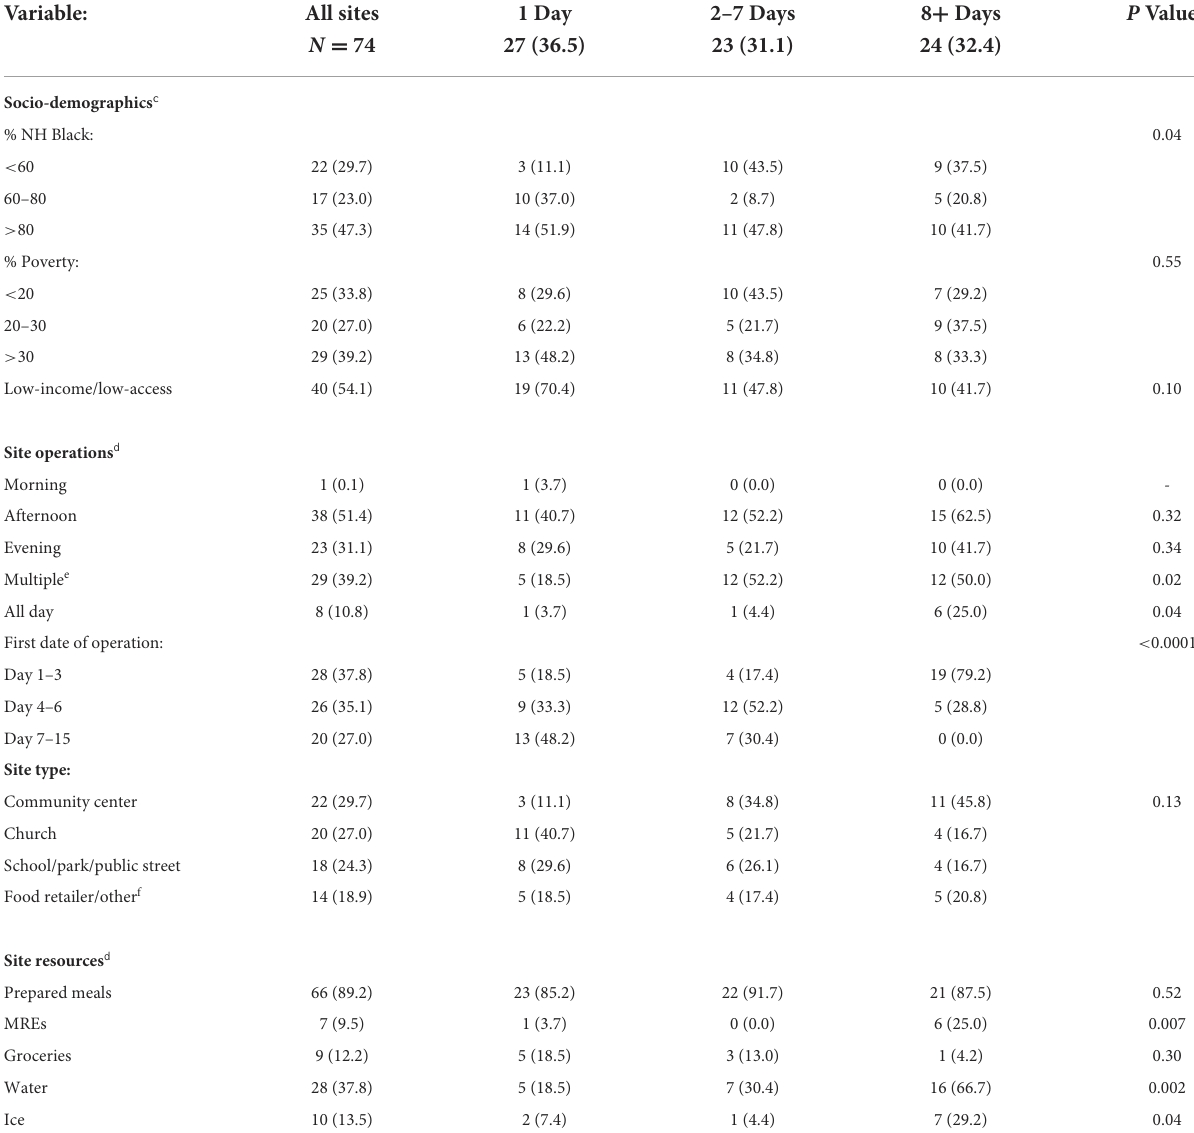
TABLE 1 Food distribution site demographics, operations, and resources by total days of operation, N (%).